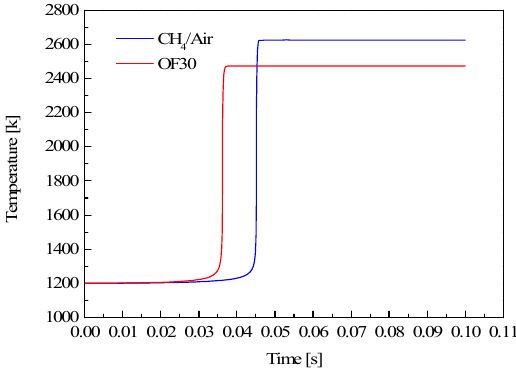
Figure 8. Ignition delay time at equivalence ratio = 1, temperature 1200 K.